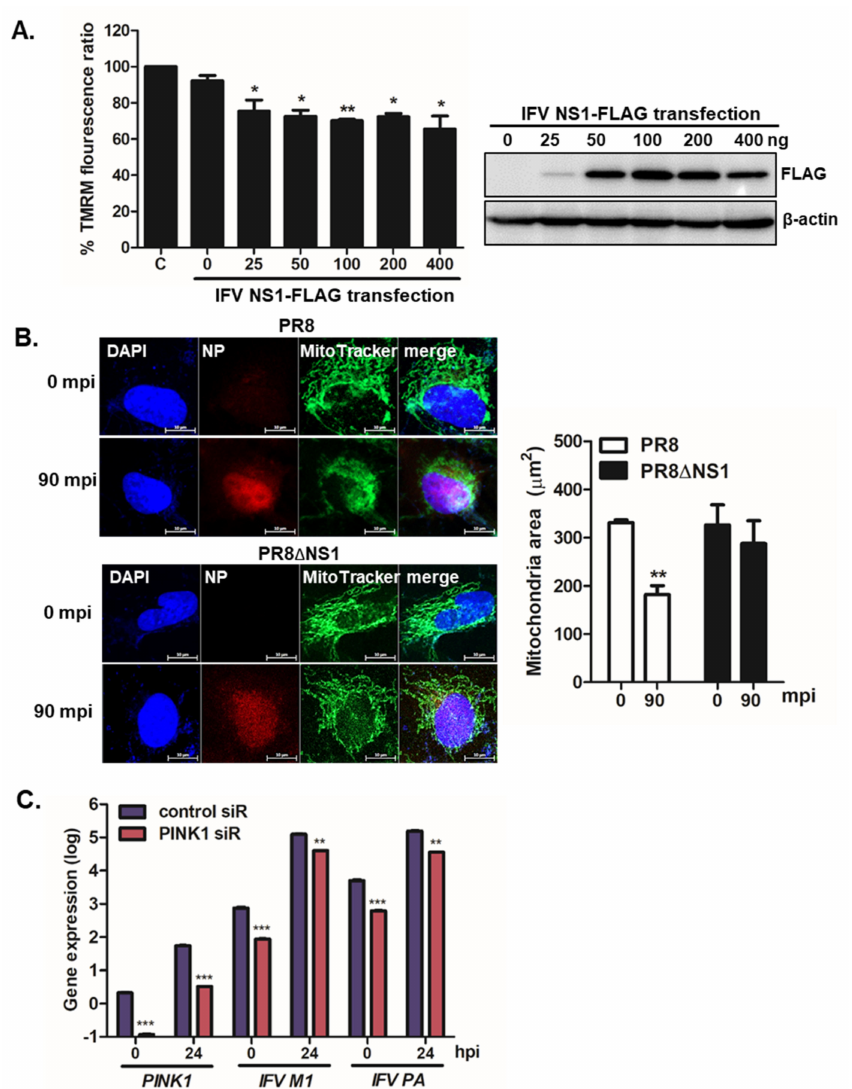
Figure 3. IFV NS1 depolarizes MMP and enhances mitochondrial fragmentation. ( A ) A549 cells were transiently transfected with the indicated amount of NS1-FLAG plasmid for 24 h and were then treated with CCCP for 2 h. Relative tetramethylrhodamine methyl ester (TMRM) intensities in each group of live cells were measured using the Varioskan LUX multiplate reader (on the left). ( C ) indicates treatment with CCCP alone. TMRM fluorescence from CCCP ( C ) alone-treated cells was set to 100% and other samples (NS1-transfected cells treated with CCCP) were represented by % TMRM fluorescence ratio. Efficient transfection of IFV NS1 is shown by immunoblot analysis (on the right). ( B ) A549 cells were infected with PR8, or PR8dNS1 virus for 90 min (MOI = 1). Anti-IFV nucleoprotein (NP) antibodies were used to detect NP protein (red) and MitoTracker Green (green) was used to observe mitochondrial areas; minutes post IFV infection (mpi); Scale bar = 10 µ m. Quantification of mitochondrial area is shown in the graph (n = 100). ** p < 0.01; vs. PR8-infected cells at 0 mpi ( C ) A549 cells transfected with either control or PINK1 siRNA were infected with PR8 at an MOI of 1 for the indicated time periods. The qRT-PCR results indicate the expression levels of PINK1, IFV M1, and IFV PA. * p < 0.05; ** p < 0.01; *** p < 0.001 vs. control siRNA-transfected